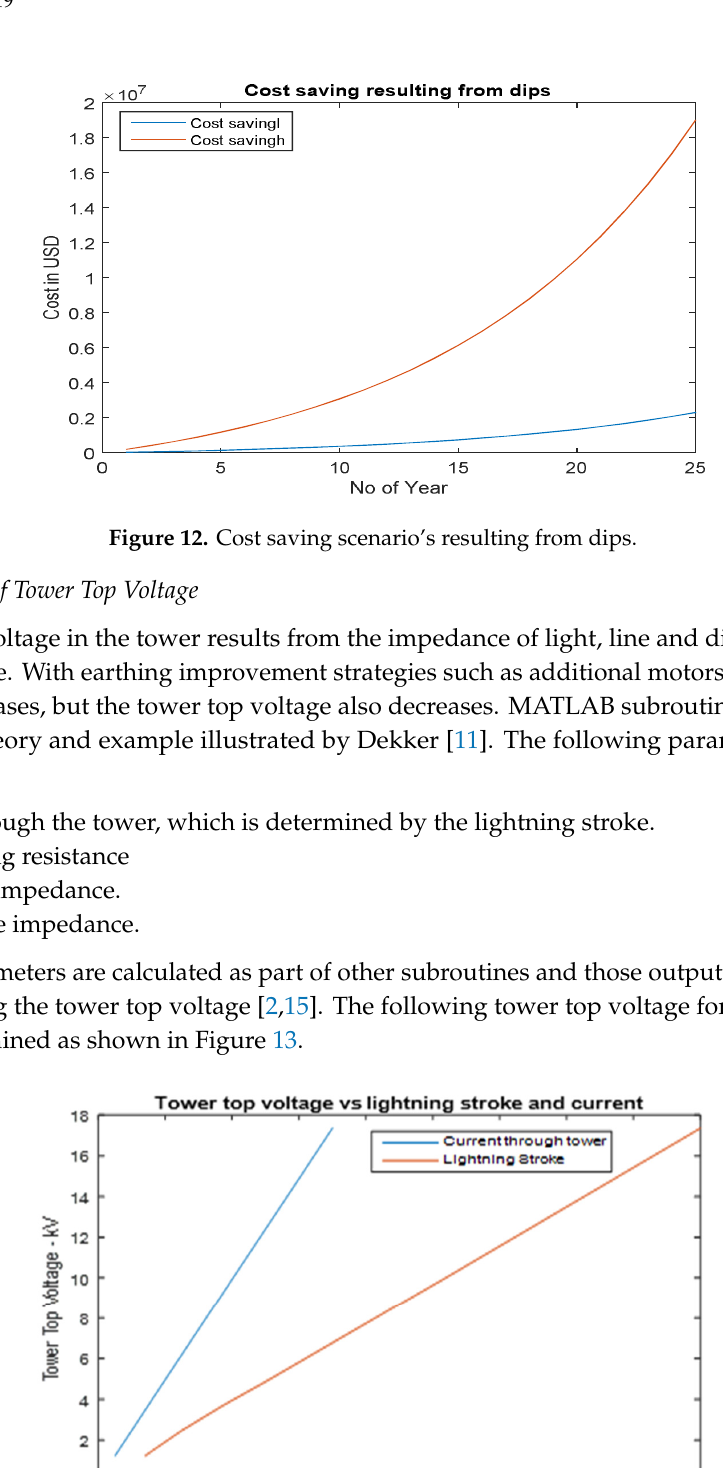
Figure 13. Top Tower voltage vs. lightning current through the tower. The only variable that suggests a linear relationship will be the intensity of the lightning strike. The magnitude of the tower’s top voltage corresponds to the flash current that passes through the tower is significant. The tower and overhead conductor’s impedance would result in the lightning current splitting [2], 15 kA of a 37.5 kA stroke would flow through the tower. This would give a peak overvoltage of 3720 kV [2,15]. The 8/20 microsecond wave shape is centered and shown in Figure 14.